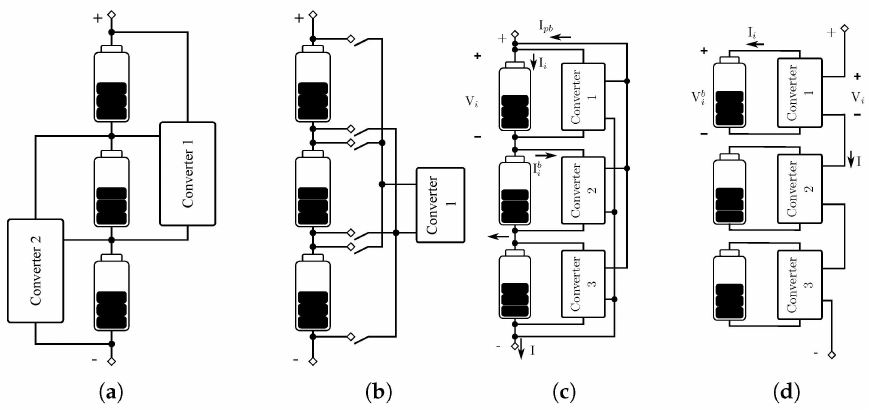
Figure 3. Equalization architectures based on energy redistribution balancing: ( a ) adjacent cell-to-cell, ( b ) direct cell-to-cell, ( c ) parallel cell-to-pack, and ( d ) series